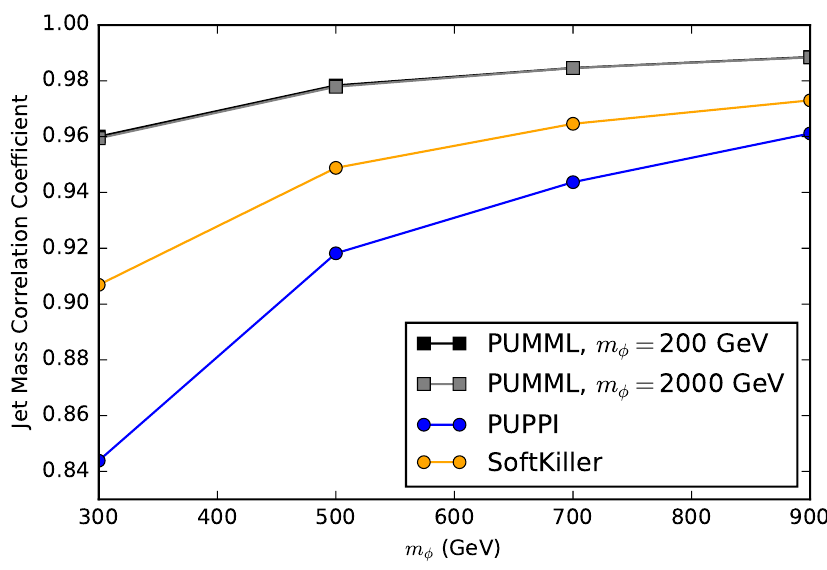
Figure 7 . Correlation coe(cid:14)cients between reconstructed and true jet masses plotted as a function of the mass of the scalar resonance with NPU=140. A spread in scalar resonances is generated in order to produce a range in jet transverse momenta. In order to assess the impact of the p T distribution used for training, one version of PUMML was trained with a scalar mass of 200 GeV (black) and one was trained with a mass of 2 TeV (gray). The two PUMML curves closely match one